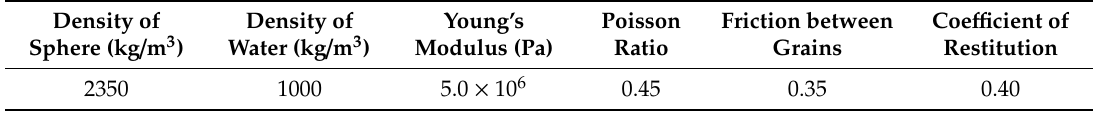
Table 1. Parameters for numerical